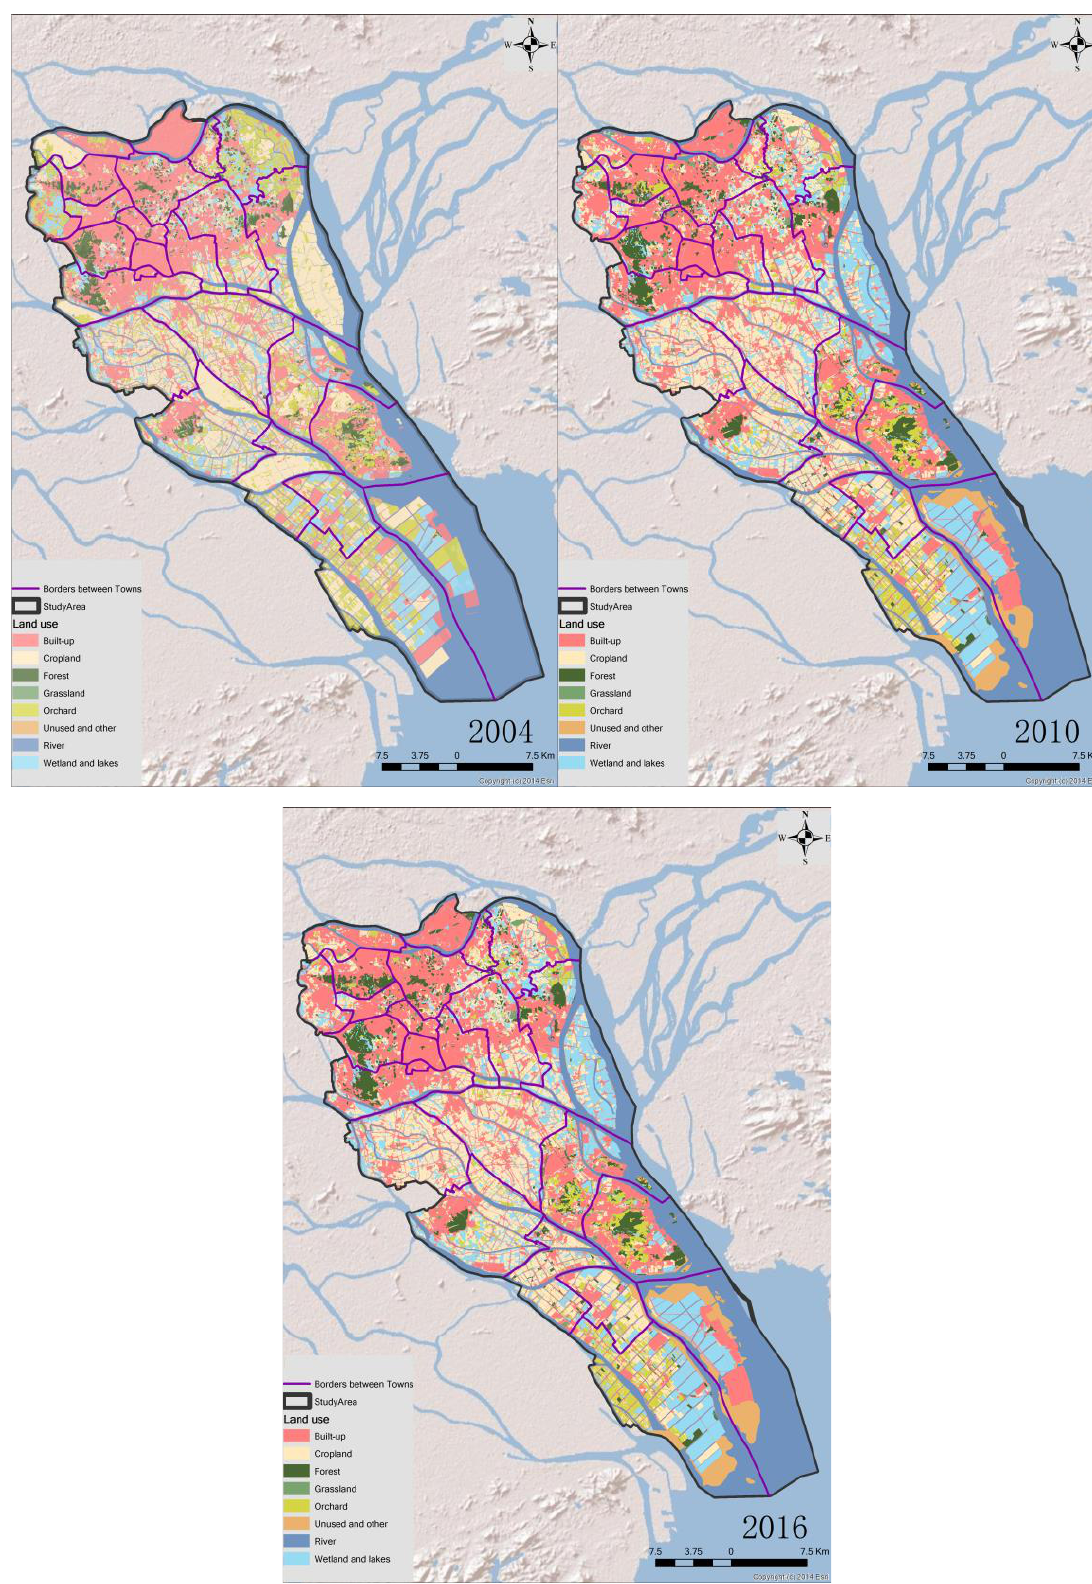
Figure 2. Land use in 2004, 2010 and 2016 (base map comes from ESRI).